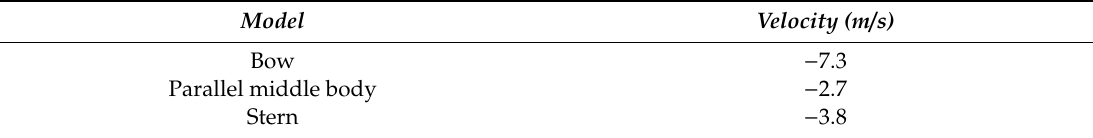
Table 4. Velocities of water entry for each section.